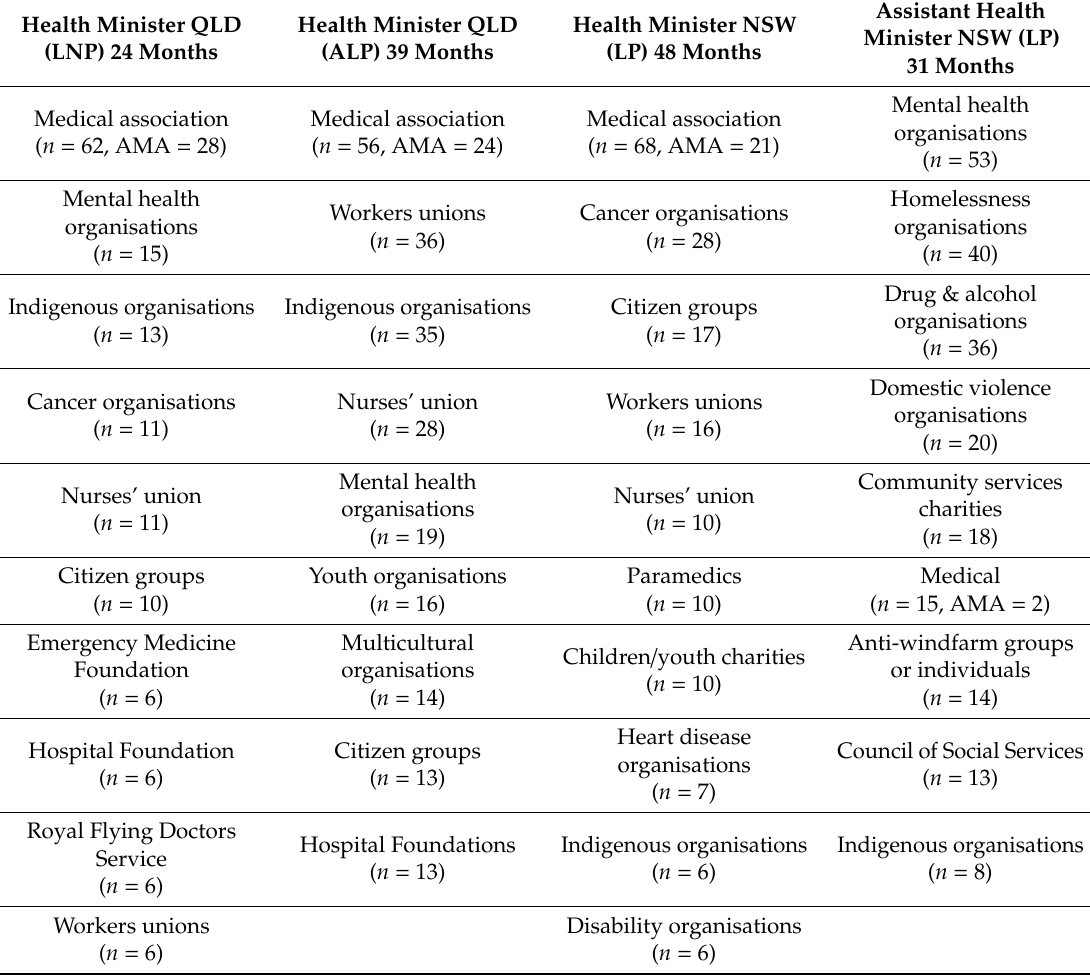
Table 3. Top recorded advocacy interactions in health ministers’ diaries (January 2013–June 2018)